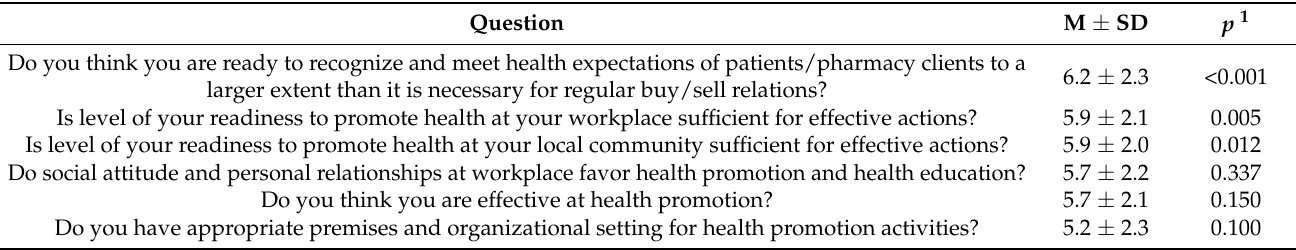
Table 4. Pharmacy students’ assessment of personal readiness to promote health (N = 206). Question M ± SD p 1